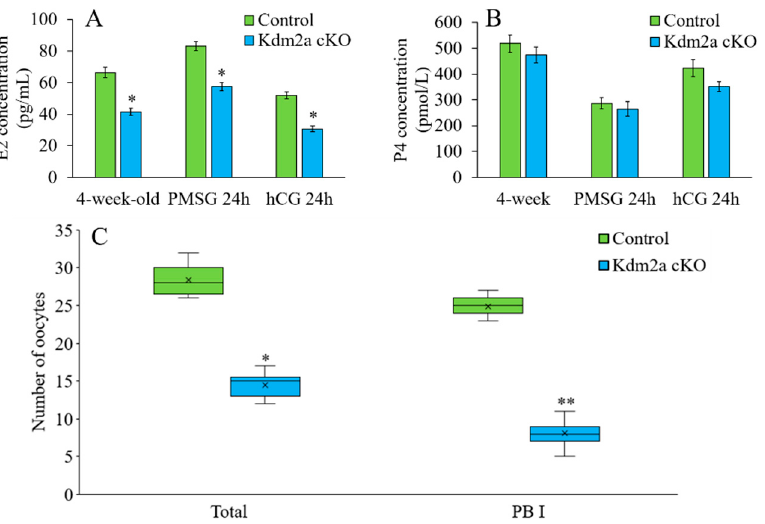
Figure 6. Kdm2a cKO mice exhibited lower serum estradiol without changing progesterone. ( A ) The concentrations of estradiol (E2) in the serum samples prepared from control and Kdm2a cKO mice at 4-weeks-old (n = 5), at 24 h after PMSG injection (n = 5), and 24 h after hCG injection (n = 5). ( B ) The concentrations of progesterone in the serum samples of control and Kdm2a cKO mice at 4-weeks-old (n = 5), at 24 h after PMSG injection (n = 5), and 24 h after hCG injection (n = 5). ( C ) The number of oocytes were ovulated after PMSG and hCG treatment. * Significant difference ( p < 0.05), ** Extremely significant difference ( p < 0.01).